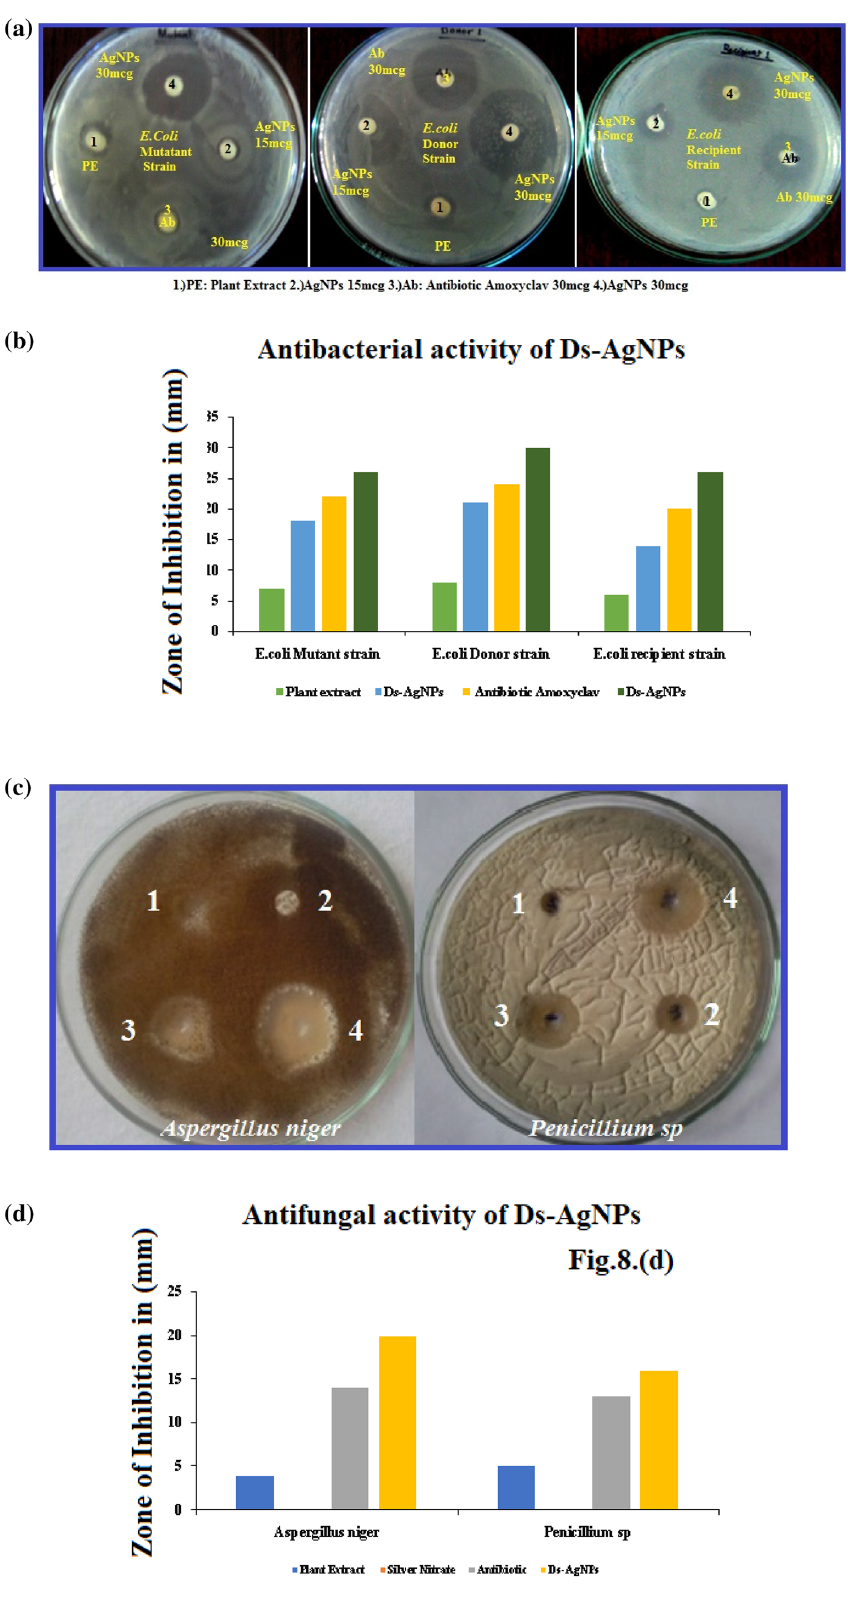
Figure 8. ( a ) Antibacterial activity of AgNPs on Gram negative antibiotic resistant E. coli strains, E. coli Mutant strain, E. coli Donor strain, E. coli recipient strain. ( b ) Graphical analysis of Antibacterial activity of Ds-AgNPs on Gram negative antibiotic resistant E. coli strains E. coli Mutant strain, E. coli Donor strain, E. coli recipient strain. ( c ) Antifungal activity of AgNPs on Aspergillus niger and Penicillium sp. Aspergillus niger : (1) plant extract, (2) silver nitrate, (3) nystatin antibiotic (25mcg), (4) Ds-AgNPs. Penicillium sp.: (1) silver nitrate, (2) plant extract, (3) nystatin antibiotic (25mcg), (4) Ds-AgNPs. ( d ) Graphical representation of Antifungal activity of Ds-AgNPs on Aspergillus niger and Penicillium